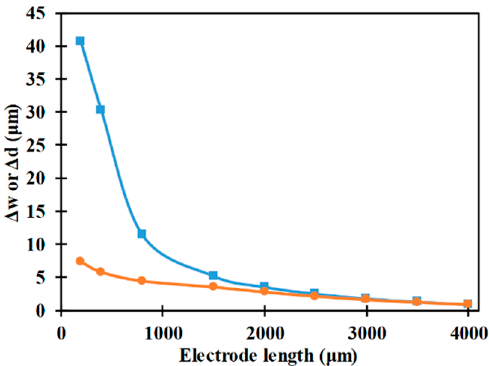
Figure 8. Variation of Δ w ( ■ ) and Δ d ( ● ) with electrode length ( r p = 2 μ m, W e = 80 μ m, L ch = L e + 200 μ m, V 1 = V 2 = 12 V pp , W ch = 200 μ m, H ch = 50 μ m).